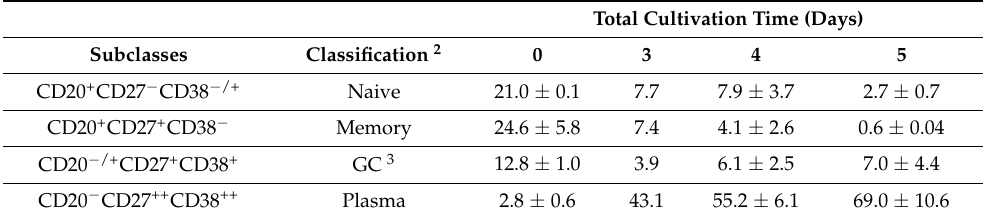
Table 4. Distribution of the B cell 1 subclasses (%) as a function of the cultivation time